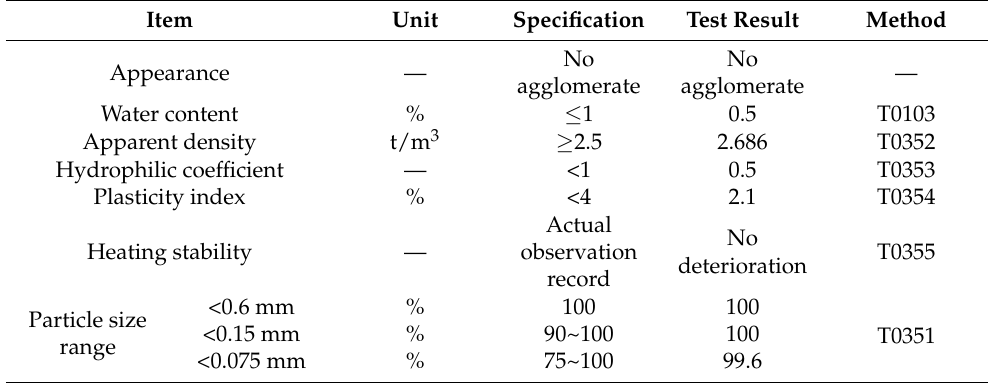
Table 5. Technical indices of